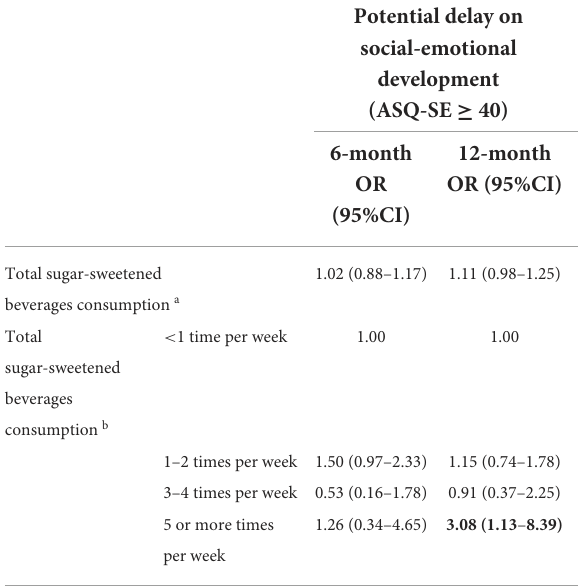
TABLE 2 Associations between maternal total sugar-sweetened beverage consumption and social-emotional development at child at 6 months and 12 months of age.